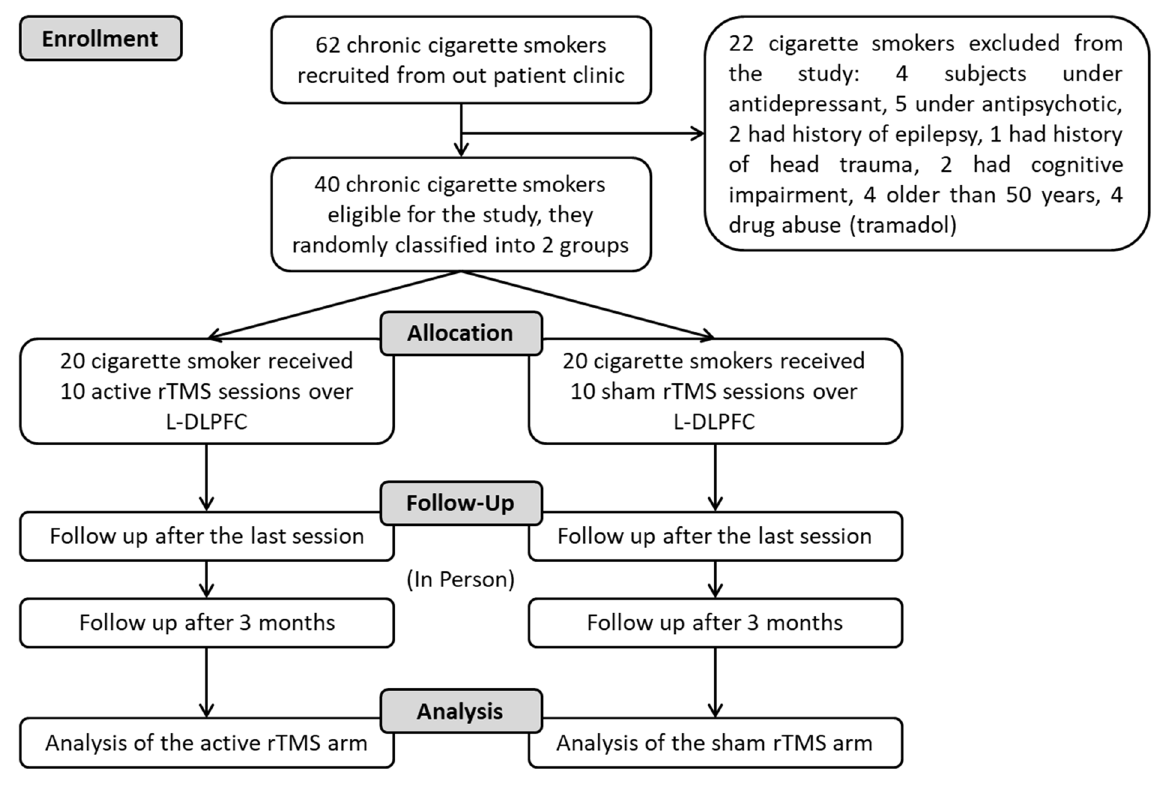
Figure 3. Flow chart of the experimental